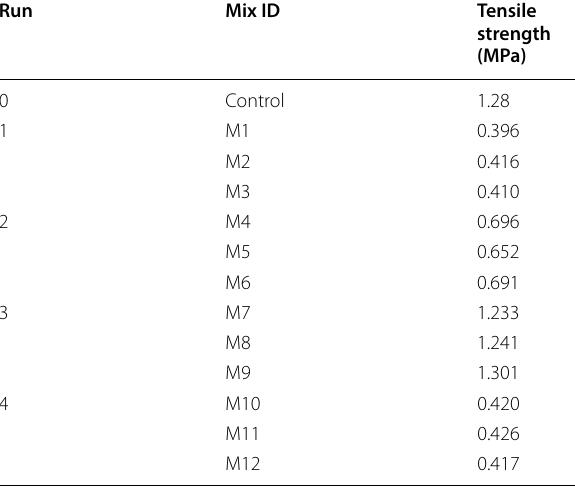
Table 5 Tensile strength test